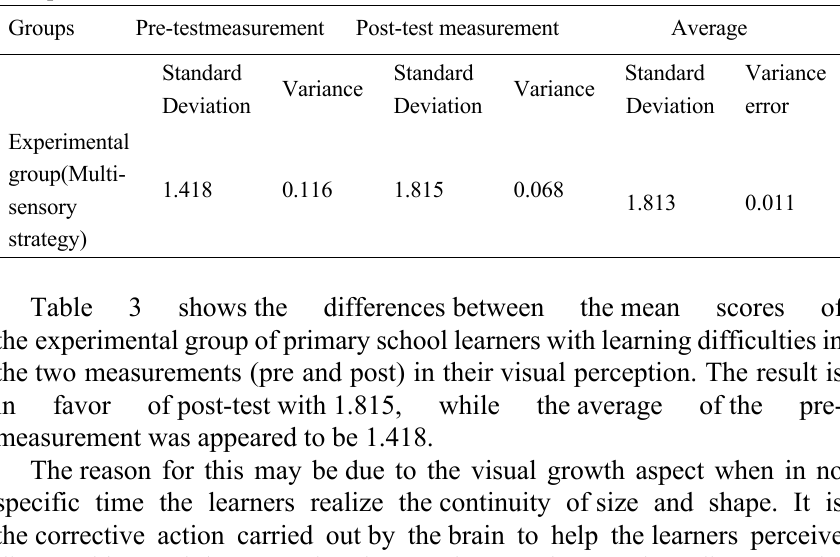
Averages and standard deviations in the two measurements: pre and post in the visual perception Groups